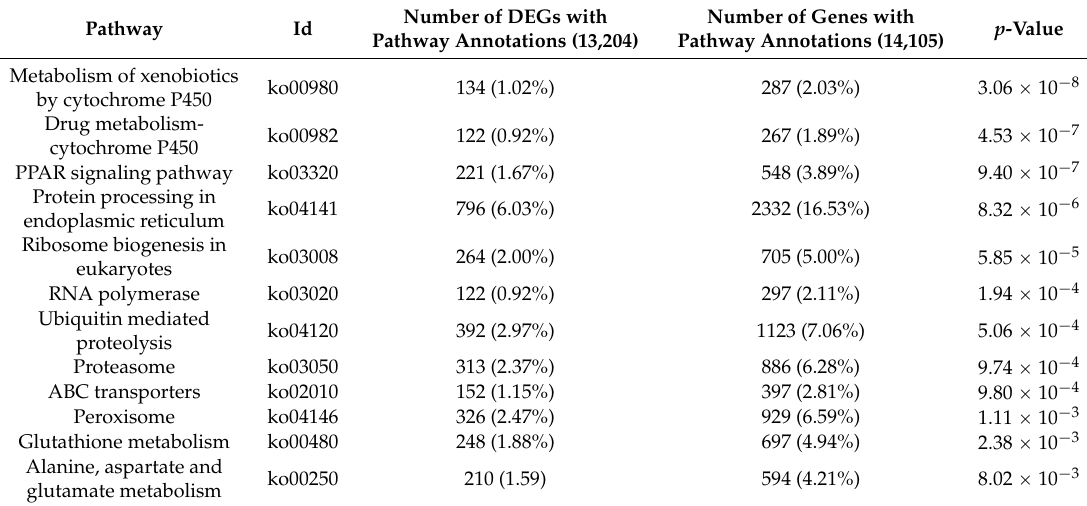
Table 3. Enriched pathways containing up-regulated genes under Pb stress.